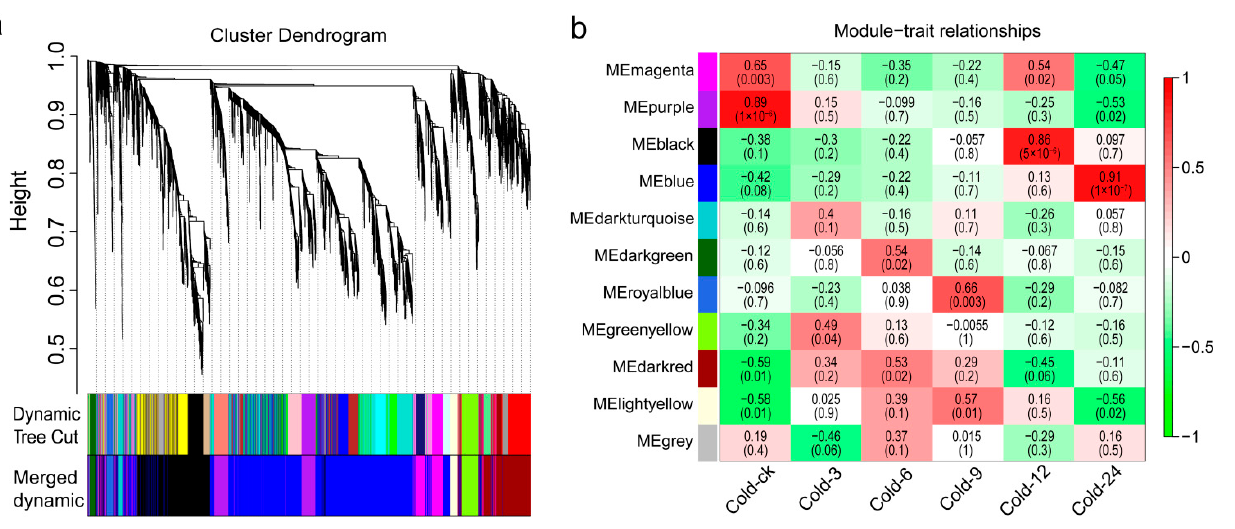
Figure 6. WGCNA analysis of DEGs. ( a ) The clustering dendrogram of DEGs identifying the WGCNA modules. ( b ) The correlation of the identified modules with the different cold treatments.